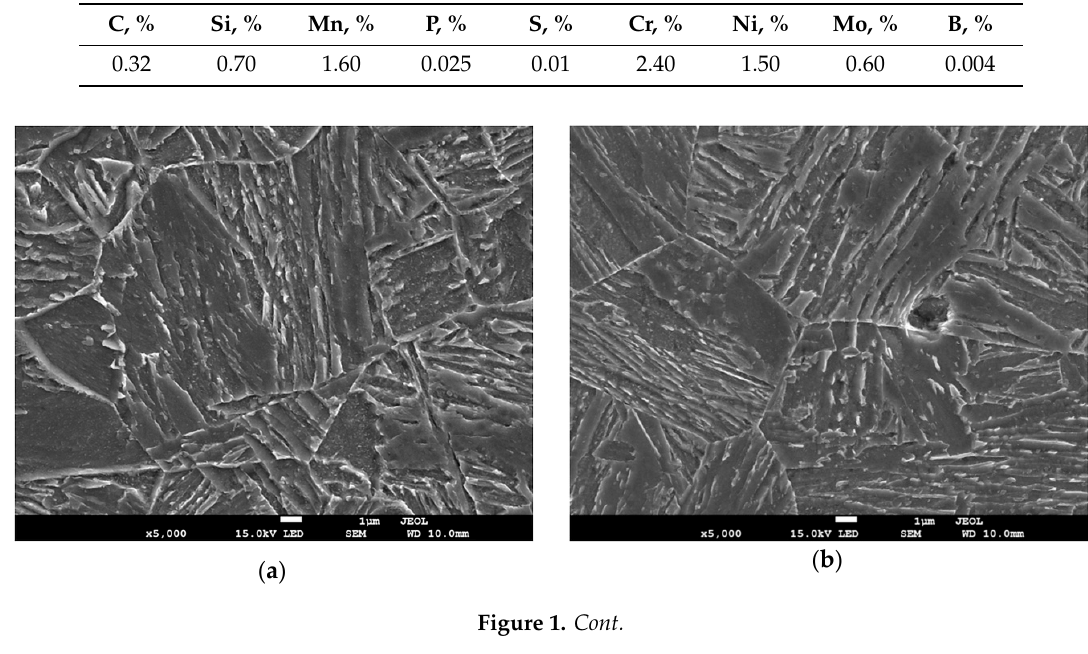
Table 1. The chemical composition of Hardox-400 steel according to [23].